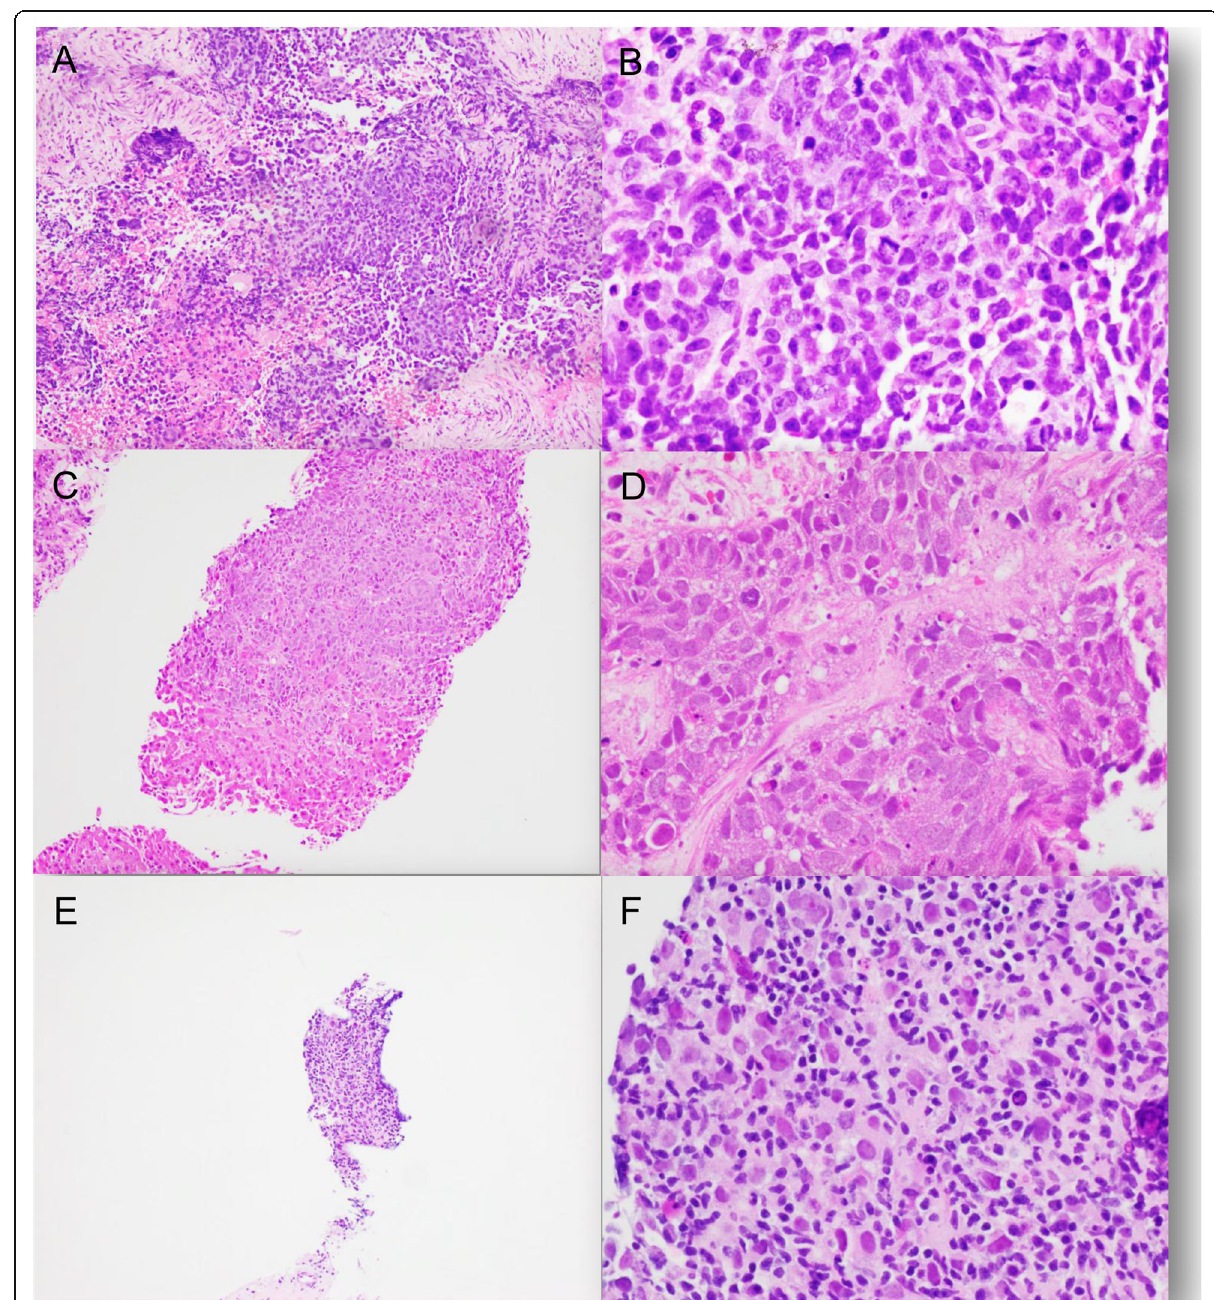
Fig. 1 a and b : Unclassifiable high grade small blue cell tumor. Tumor cells have high nuclear to cytoplasmic ratio (N/C ratio), brisk mitotic and apoptotic activity. Multinucleated giant tumor cells are also seen. Tumor cells are focally positive for pancytokeratin. Lymphoma, neuroendocrine, melanoma, skeletal muscle, and lineage specific markers are all negative (not shown). Fluorescence in-situ hybridization for EWSR1 gene is negative. (A 100x; B 400x). c and d : Unclassifiable large eosinophilic cell tumor. Tumor cells have a moderate amount of eosinophilic cytoplasm, fine chromatin and inconspicuous nucleoli. Tumor cells are positive for CK7. Neuroendocrine, melanoma, hepatocellular, kidney, adrenal and other lineage specific markers are all negative. (C 100x; D 400x). e and f : Unclassifiable neoplasm due to scant material. Cell block preparation shows one cluster of tumor cells with nuclear pleomorphism and abundant lymphoid infiltration. Limited immunohistochemical stains were performed due to limited cellularity. Tumor cells are positive for AE1/AE3, and negative for HepPar-1, arginase, TTF-1, NKX3.1, PAX8, CK7, and